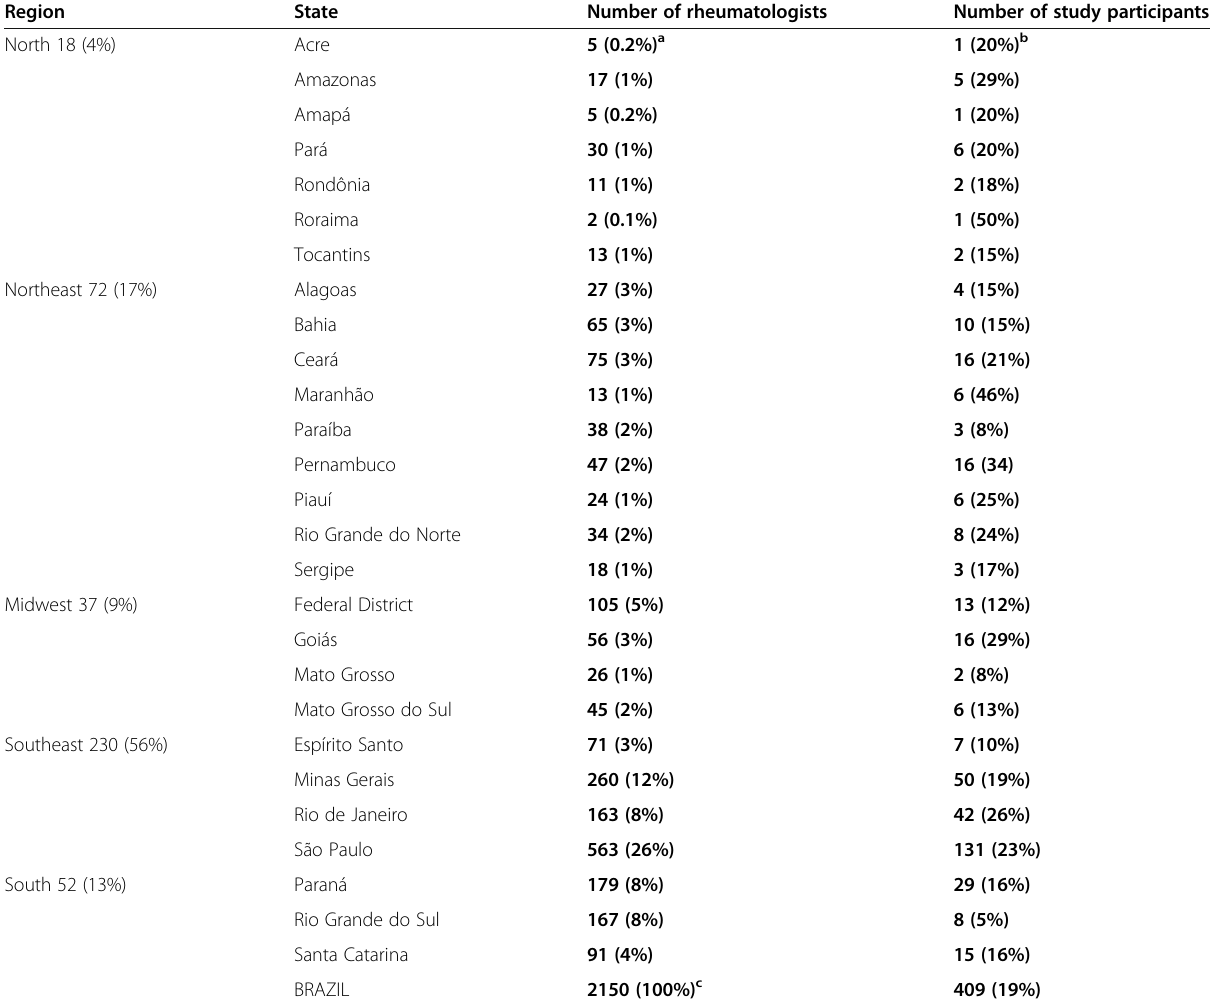
Table 1 Distribution of rheumatologists and participants according to the state of the federation